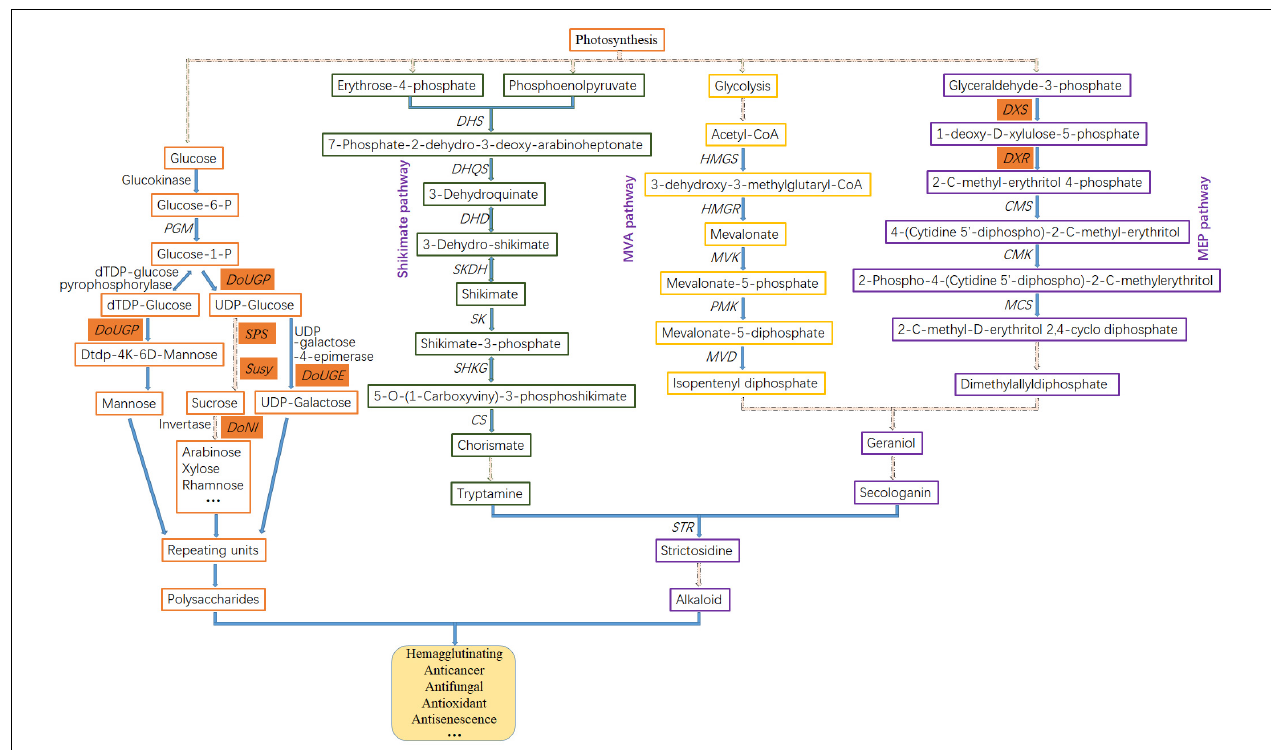
FIGURE 2 | Putative biosynthetic pathways of polysaccharide and alkaloid in Dendrobium . In the polysaccharide biosynthesis pathway, monosaccharides (mannose, glucose, galactose, arabinose, xylose, etc.) are produced through hydrolysis or hydrolysis-derivative reactions. These monosaccharides as basic building blocks and repeating units are then used to synthesize polysaccharides. In the alkaloid biosynthesis pathway, the upstream precursors are produced mainly through the Shikimate pathway, and MVA and MEP pathways. Genes in red cells indicate the cloned and functionally studied genes in Dendrobium . The dashed lines indicate multiple steps. Enzyme abbreviations are as follows: PGM , phosphoglucomutase; UGP , UDP-glucose pyrophosphorylase; SPS , sucrose-phosphate synthase; Susy , sucrose synthase; DHS , 3-dexoy-7-phosphoheptulonate synthase; DHQS , 3-dehydroquinate synthase; DHD , 3-dehydroquinate dehydratase; SKDH , shikimate dehydrogenase; SK , shikimate kinase; SHKG , 3-phosphoshikimate 1-carboxyvinyltransferase; CS , chorismate synthase; HMGS , hydroxymethylglutaryl-CoA synthase; HMGR , 3-hydroxy-3-methylglutaryl CoA reductase; MVK , mevalonate kinase; PMK , phosphomevalonate kinase; MVD ,